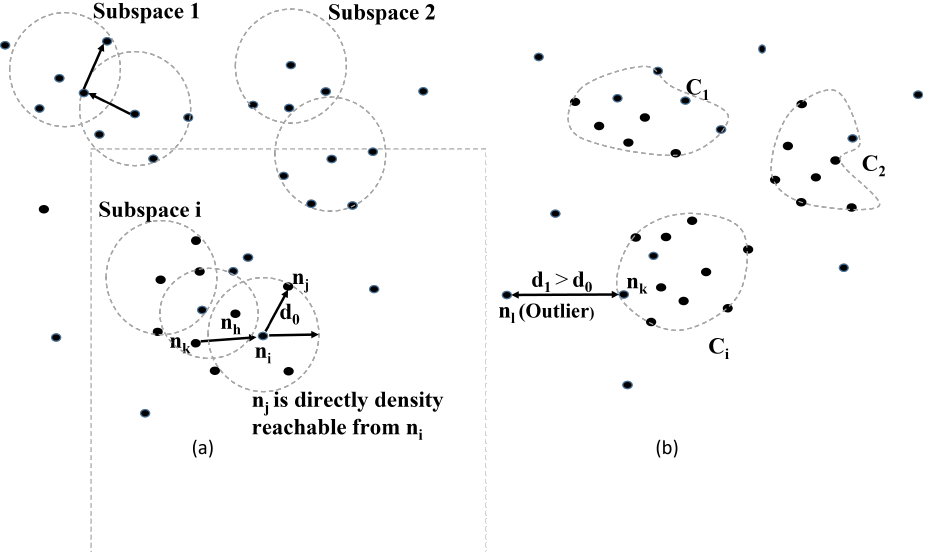
Figure 3. Arbitrary subspace clusters in the HSFZ: ( a ) Node density-reachability, ( b ) Node density- connected arbitrary subspace